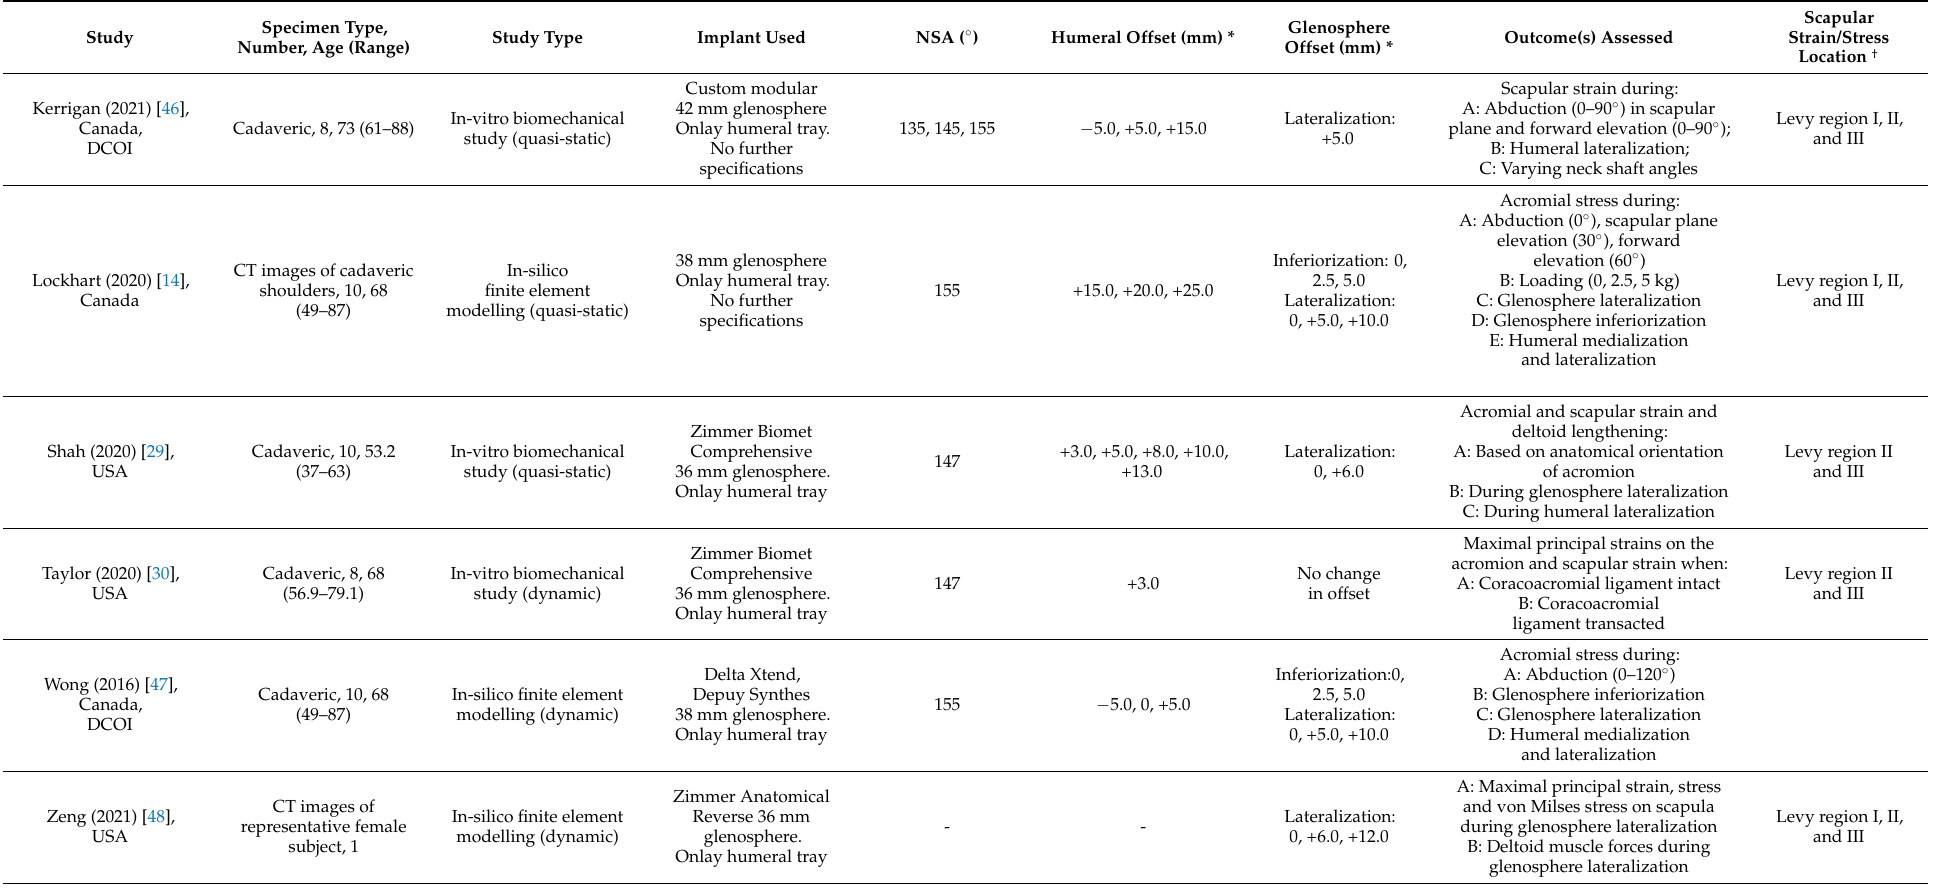
Table 1. Characteristics of the included